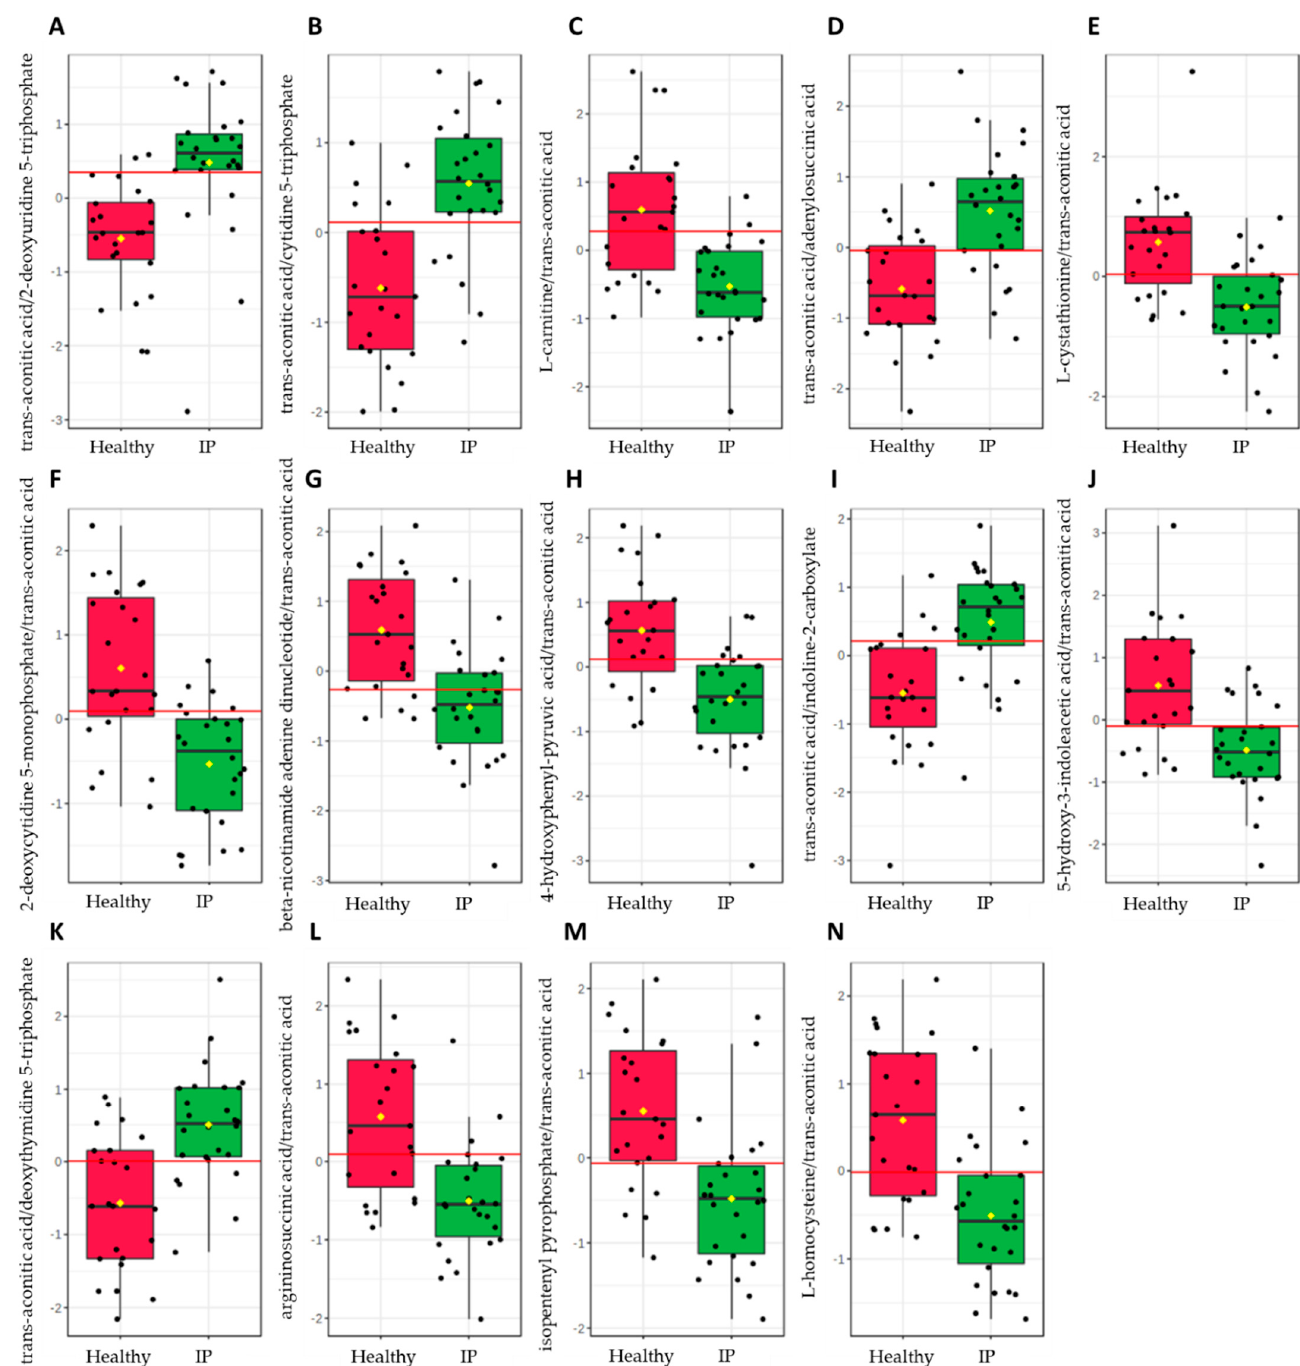
Figure 5. Significant metabolite ratios ( p -value ≤ 0.05) with a good diagnostic value (AUC ≥ 0.8) in increased intestinal permeability (IP) subjects from the plasma samples identified via the biomarker analysis of the central carbon metabolism intermediates using MetaboAnalyst 5.0 (Biomarker Anal- ysis Toolbox, Quebec, Canada). ( A ) trans-aconitic acid/2-deoxyuridine 5-triphosphate, ( B ) trans-ac- onitic acid/cytidine 5-triphosphate, ( C ) L-carnitine/trans-aconitic acid, ( D ) trans-aconitic acid/ade- nylosuccinic acid, ( E ) L-cystathionine/trans-aconitic acid, ( F ) 2-deoxycytidine 5-monophos- phate/trans-aconitic acid, ( G ) beta-nicotinamide adenine dinucleotide/trans-aconitic acid, ( H ) 4-hy- droxyphenyl-pyruvic acid/trans-aconitic acid, ( I ) trans-aconitic acid/indoline-2-carboxylate, ( J ) 5- hydroxy-3-indoleacetic acid/trans-aconitic acid, ( K ) trans-aconitic acid/deoxythymidine 5-triphos- phate, ( L ) argininosuccinic acid/trans-aconitic acid, ( M ) isopentenyl pyrophosphate/trans-aconitic acid, and ( N ) L-homocysteine/trans-aconitic acid.